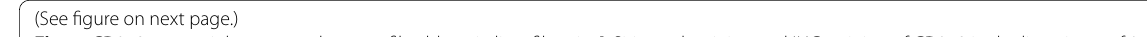
Fig. 1 CD248 was mainly expressed on myofibroblasts in liver fibrosis. A Sirius red staining and IHC staining of CD248 in the liver tissue of 9 heathy controls and 40 patients with liver cirrhosis. B Quantitative analysis of the data in A . C Sirius red staining and IHC staining of CD248 in the liver tissue of CCl 4 ‑induced mice. D Quantitative analysis of the data in C . E , F qRT‑PCR and western blotting analysis to show the increased expression of α‑SMA, Collagen I, and CD248 in the liver tissues of CCl 4 ‑induced mice (n 3 in B – F ). G IF staining images showing the colocalization = of CD248 and α‑SMA in the liver tissue of CCl 4 ‑induced mice. Representative images are shown. Scale bar, 100 μm; ** p < 0.01, *** p < 0.001. IHC immunohistochemistry, qRT-PCR quantitative real‑time reverse transcription polymerase chain reaction, α-SMA alpha smooth muscle actin,